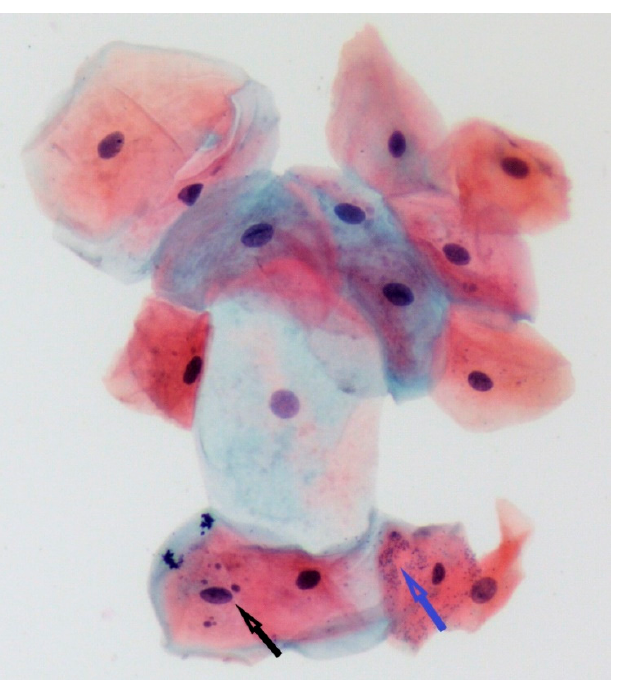
Figure 1. Specimen from conventional cigarette smoker. One cell with 4 MN was observed in a field with 15 epithelial cells. MN were identified based on their well-defined shape, size (less than 1/3 of the nucleus), similar color and refractility with the nucleus and absence of any connection to it (bridge) (black arrow). Microorganisms are recognizable as small, numerous bodies inside and between epithelial cells (blue arrow). (Pap stain, x20).